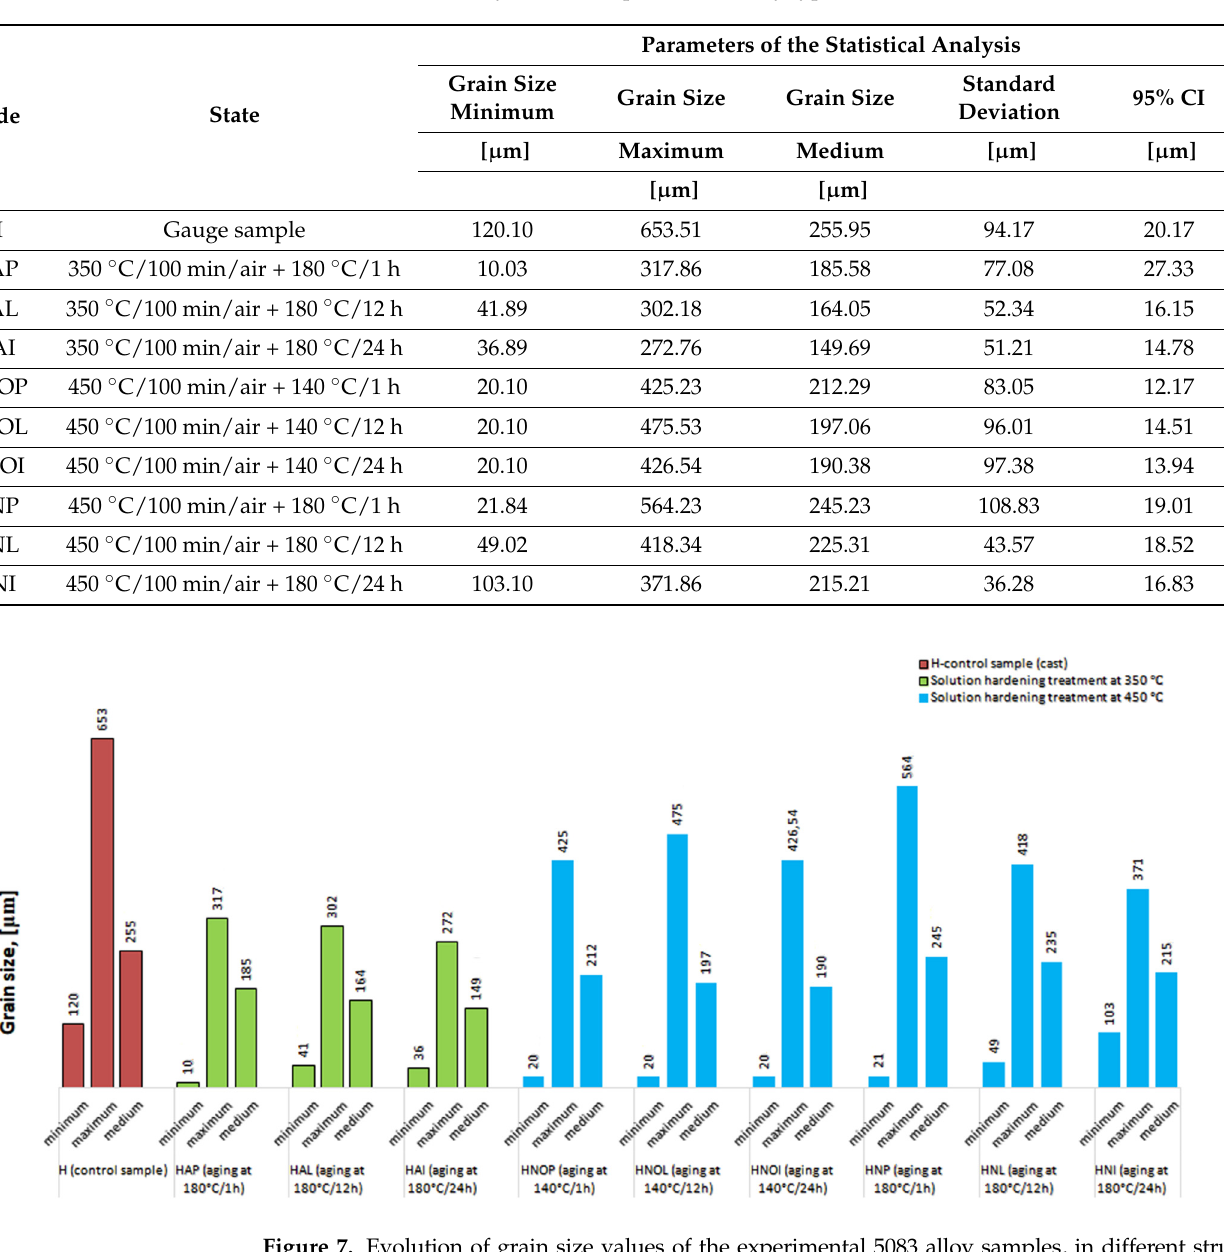
Figure 7. Evolution of grain size values of the experimental 5083 alloy samples, in different struc- tural state .